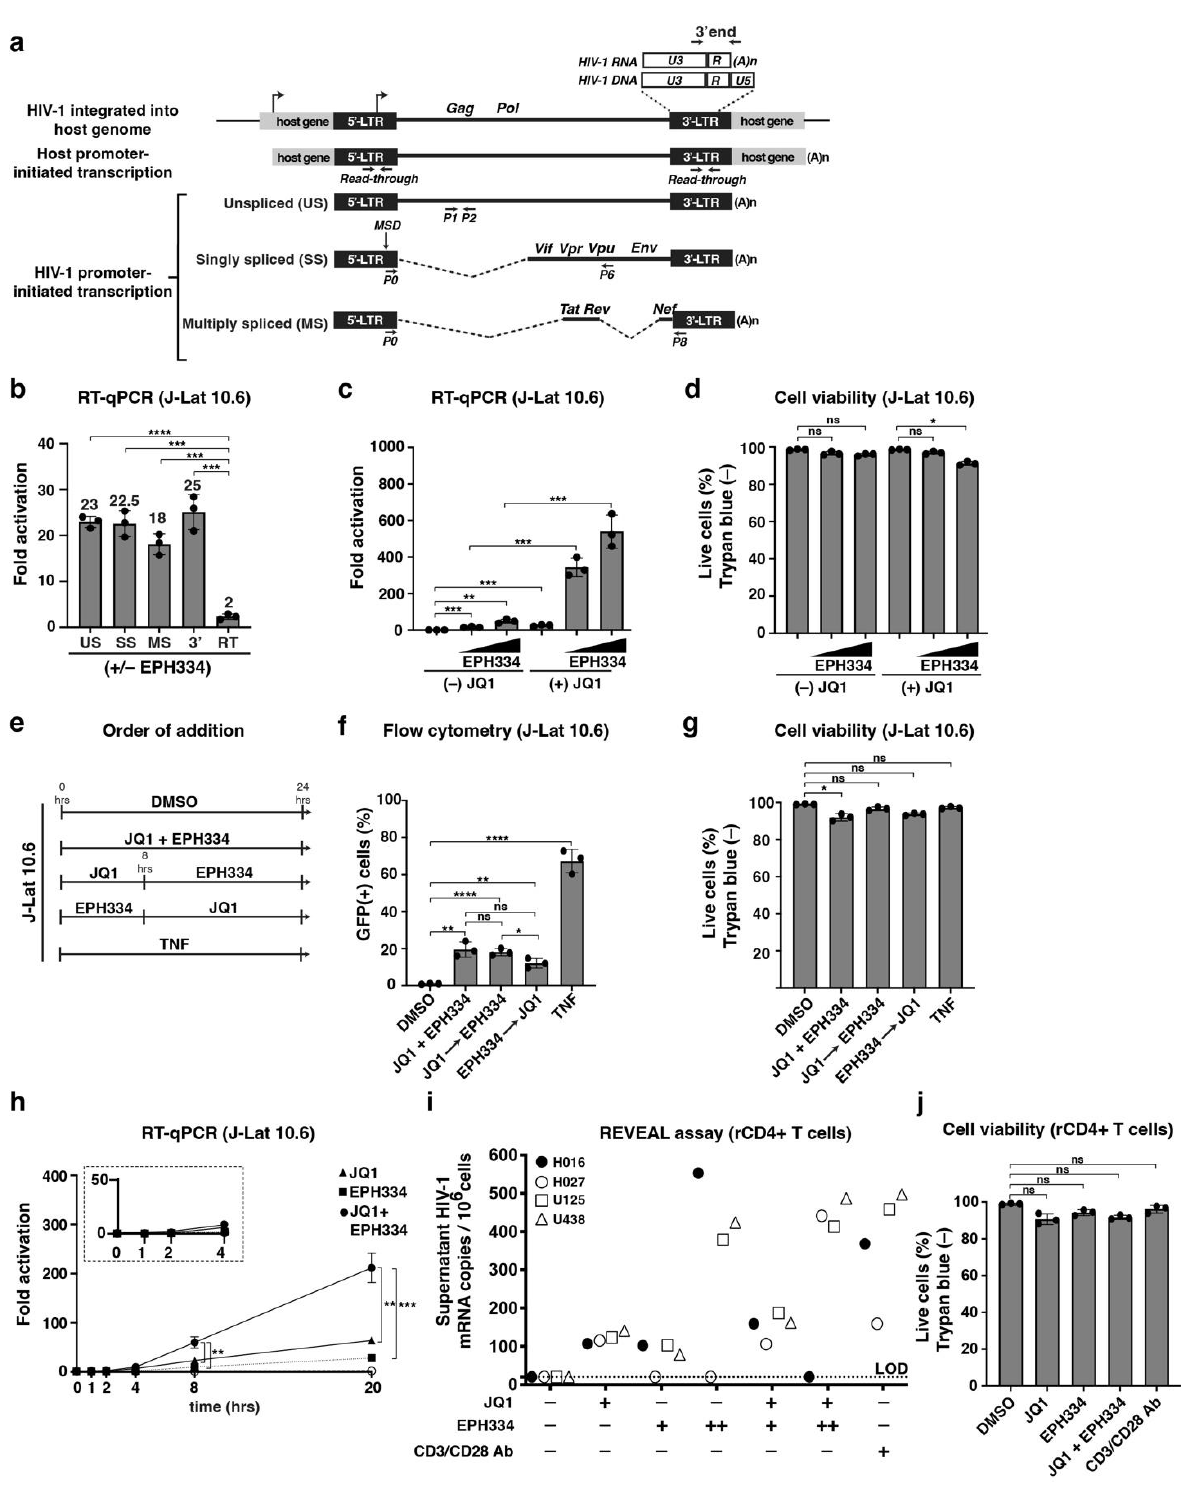
Figure 2. SMOREs induce HIV-1 promoter-initiated transcription, HIV-1 RNA processing, and combinatorial reactivation with bromodomain inhibitors. ( a ) Scheme of HIV-1 RNA transcription, splicing, and 3′ -end processing. Using a common multiple splice donor (MSD) present at the 5 ′ -end of the pre-mRNA, HIV-1 RNA is correctly spliced in the singly spliced (SS) and multiply spliced (MS) forms. A primer pair to measure read-through (RT) transcripts was also included. The arrow indicates the transcription start site (TSS) within the 5′ -LTR. ( b ) SMOREs induce normal HIV-1 RNA splicing and 3′ -end processing. Data are representative of one SMORE (EPH334). J-Lat 10.6 cells were treated with EPH334 (1 μ M) for 24 h and RNA isolated . Quantitation of HIV-1 RNAs was done with RT-qPCR assays with the indicated primers, normalized to RPL19 (mean ± SEM; n = 3)